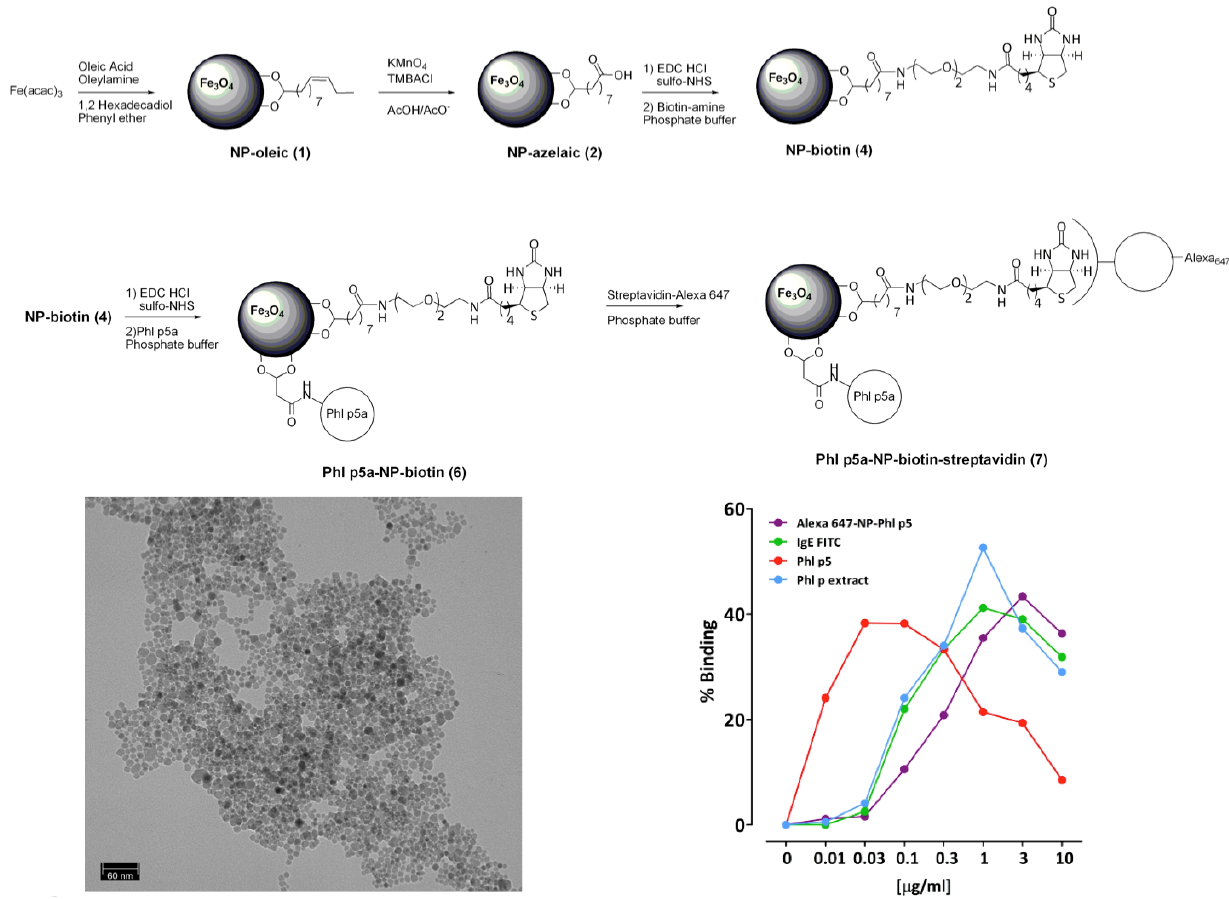
Figure 7. Synthesis of multifunctional IONPs by the direct chemical modification of oleic acid. The attachment of allergen Phl p5a and a fluorophore, via biotin-streptavidin interaction, was done by amide formation with the carboxylic groups generated. TEM image of the final IONPs ( bottom left ). Immunogenicity of the synthesized nanoparticles compared to non-functionalized particles, grass pollen extract and pure protein ( bottom right ). Reproduced from [87]. Copyright 2012, John Wiley & Sons,